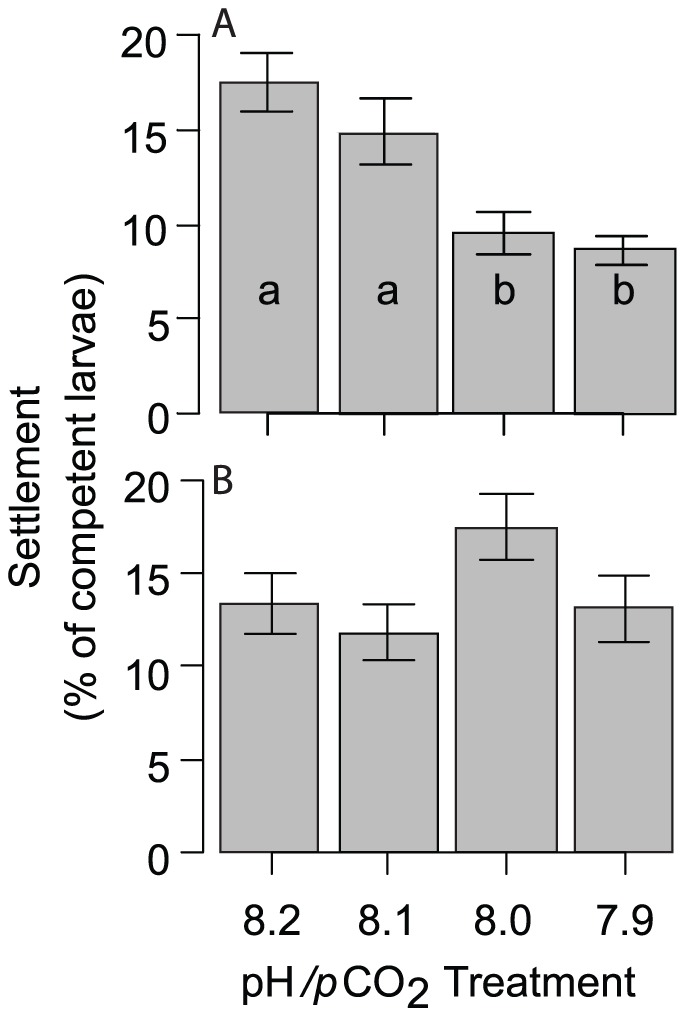
A) Settlement success of A. planci larvae on CCA and biofilms exposed for 85 d in water with pre-industrial, present day control or two near future CO2 conditions. B) Control experiment with CCA all pre-incubated under ambient conditions, and only the experimental water differing in pH/pCO2. The pH values given on the x-axis represent target values on the NBS scale (see Table 1). Error bars represent standard errors, means with the same index letters are not significantly different (Tukey-Kramer posthoc, test, p>0.05). A